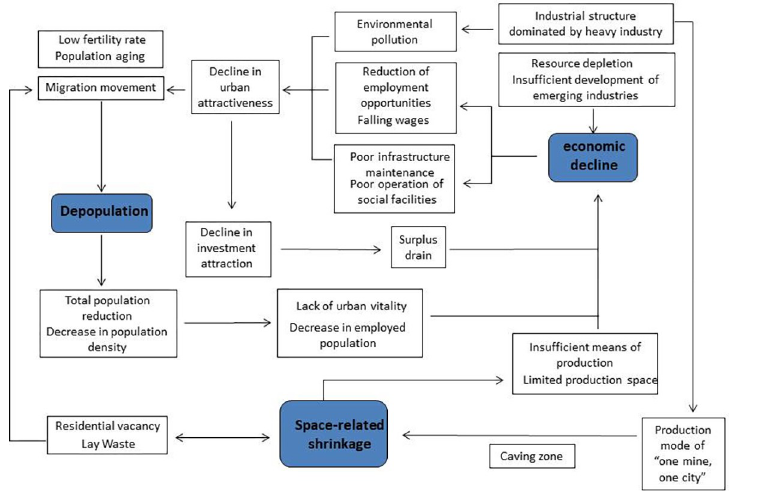
Fig 8. Driving mechanism of regional shrinkage of the three provinces in the northeast of